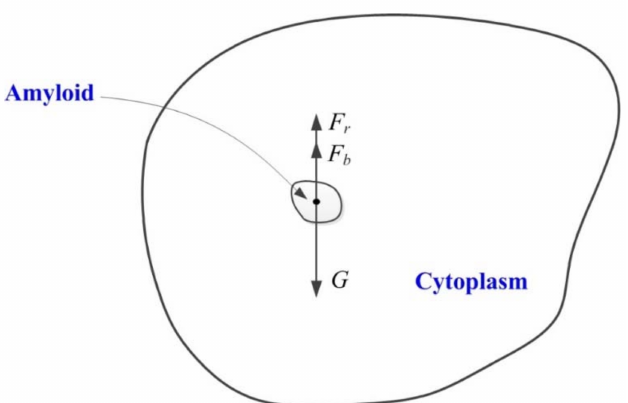
Figure 1. Dynamics model of amyloplasts sedimentation in cytoplasm. The big black irregular circle represents the root columella cell. The small black irregular circle represents the amyloplast (amyloid). F is the combined force shown by the amyloplasts, G is the gravity of the amyloplasts, F b is the buoyancy of the amyloplasts, and F r is the viscous resistance of the amyloplasts when they move in the